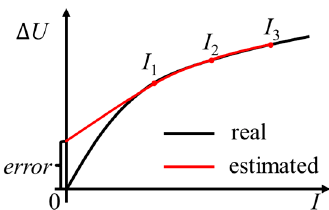
Figure 5. Error at I = 0 when estimating the ∆ U – I function with large-current data, due to the nonlinear ∆ U – I relationship.